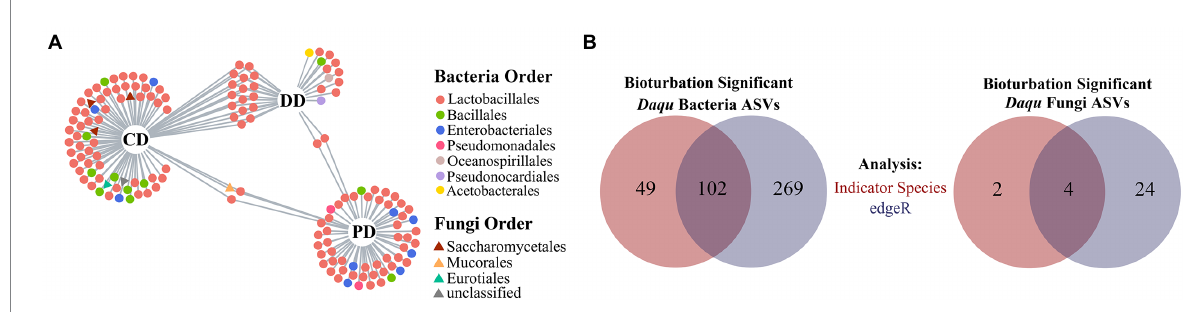
FIGURE 4 Defining the bs ASVs in which the MTD microbial communities respond significantly to bioturbation. (A) Bipartite networks display the distribution of differential ASVs ( br ASVs). These ASVs are positively and significantly associated ( p < 0.05) with one or more of the MTD types. (B) Venn diagrams show the number of ASVs significantly responding to bioturbation identified with specific ASVs of bioturbation (red) and by edgeR (blue). These ASVs are defined as bioturbation responding significantly ASVs ( bs